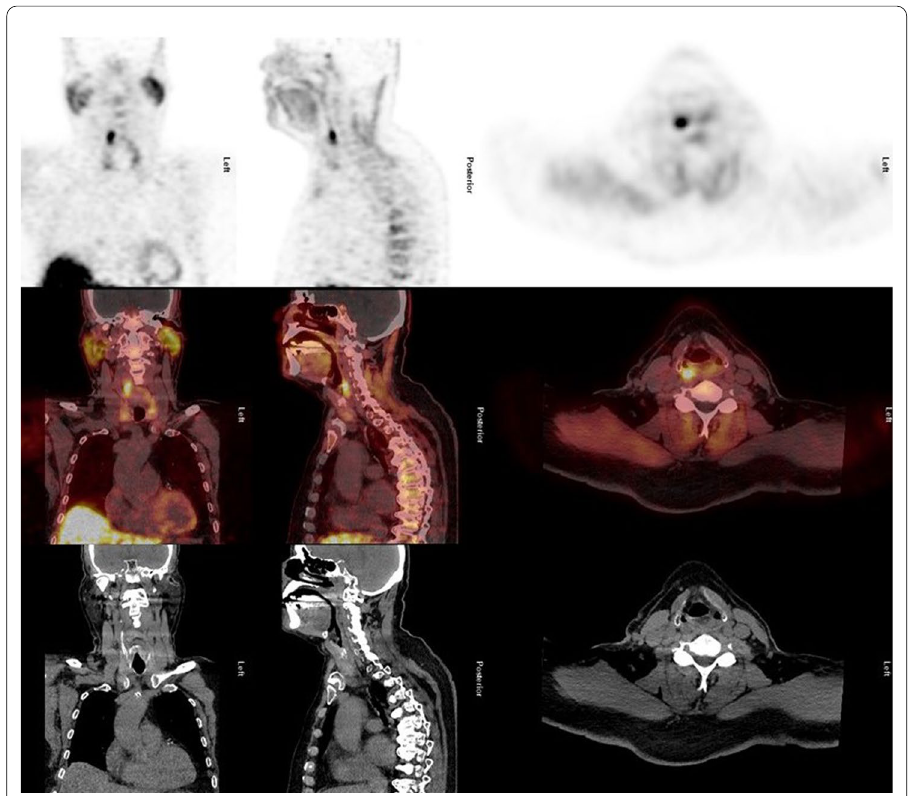
Fig. 1 Upper panel: [ 18 F]fluorocholine PET images at the level of the undescended PTA. Middle panel: overlay of the [ 18 F]fluorocholine PET and high-dose CT images at the level of the undescended PTA. Lower panel: high-dose CT images at the level of the undescended PTA. Left, middle and right columns: coronal, sagittal and transversal views,